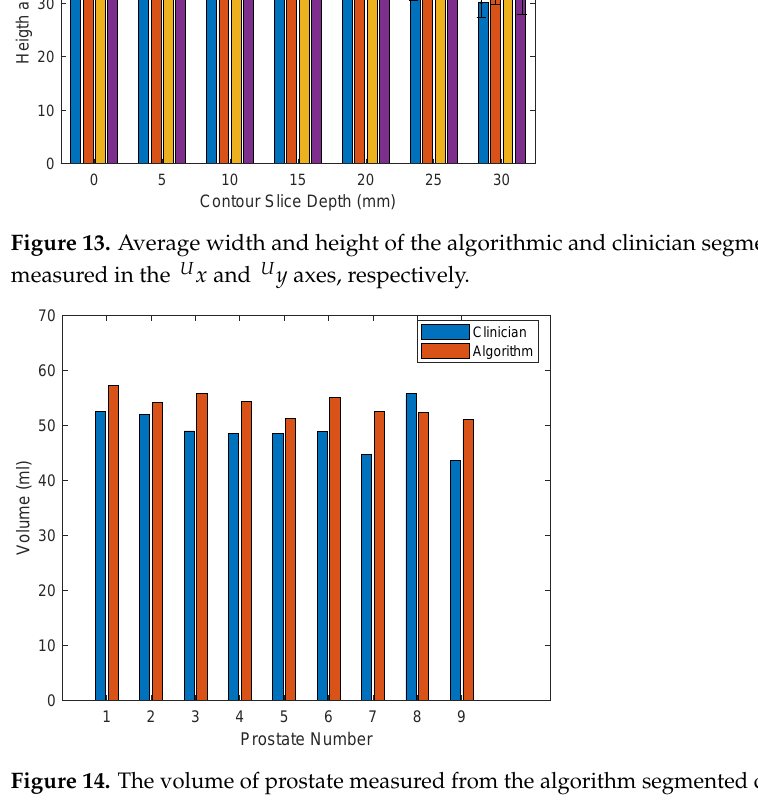
Figure 14. The volume of prostate measured from the algorithm segmented contours compared with clinician-segmented contours for the same prostate image